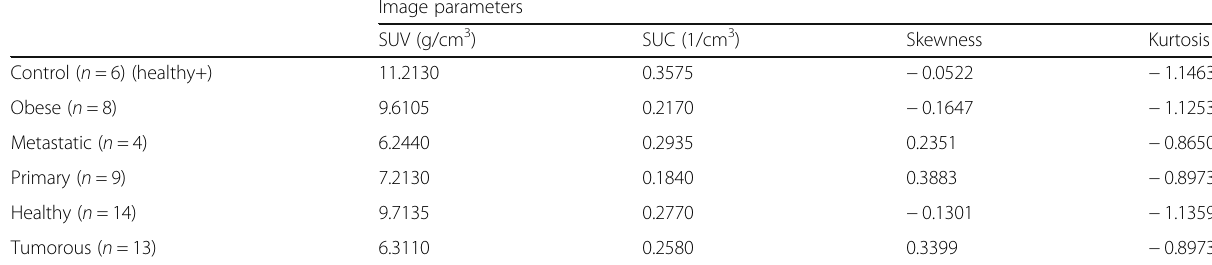
Table 2 Median value of the parameters in each population and group Image parameters